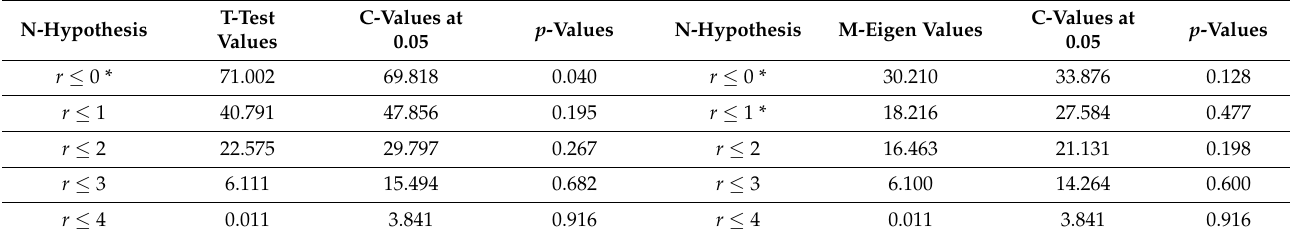
Table 8. Johansen cointegration test statistics.